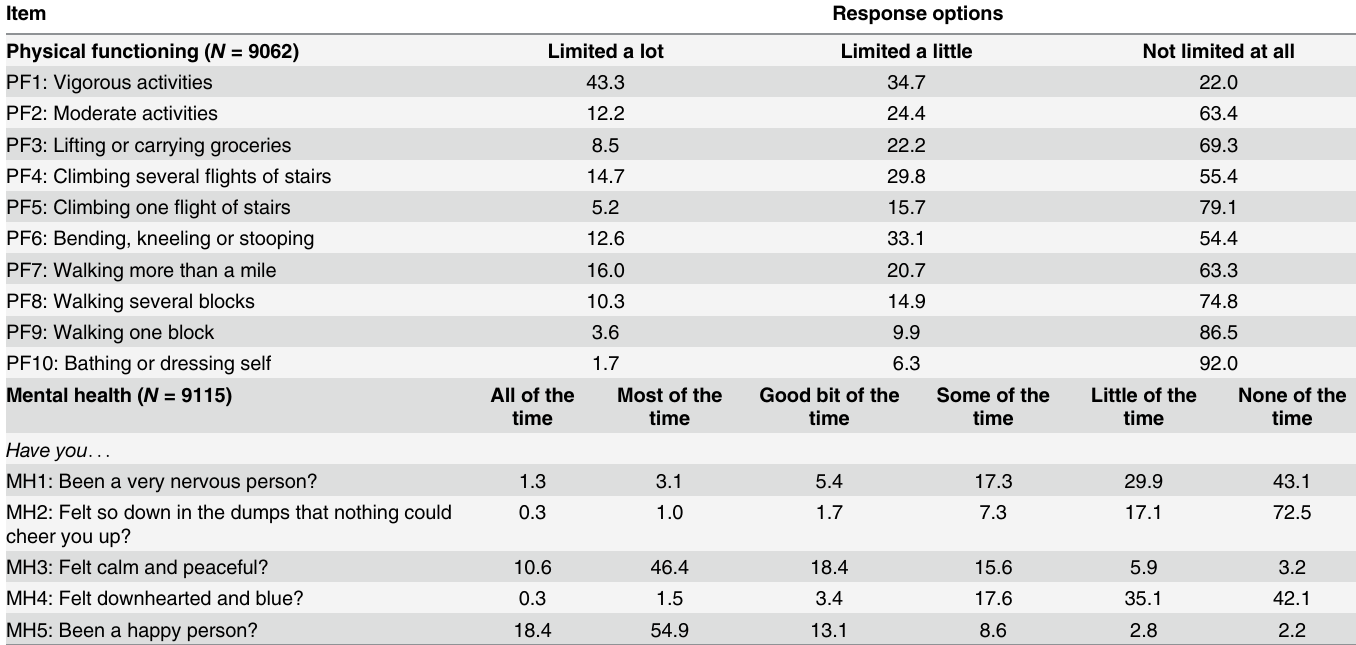
Table 1. Percentage distribution of item responses on the SF-36 physical functioning and mental health sub-scale items in the Canadian Multicen- tre Osteoporosis